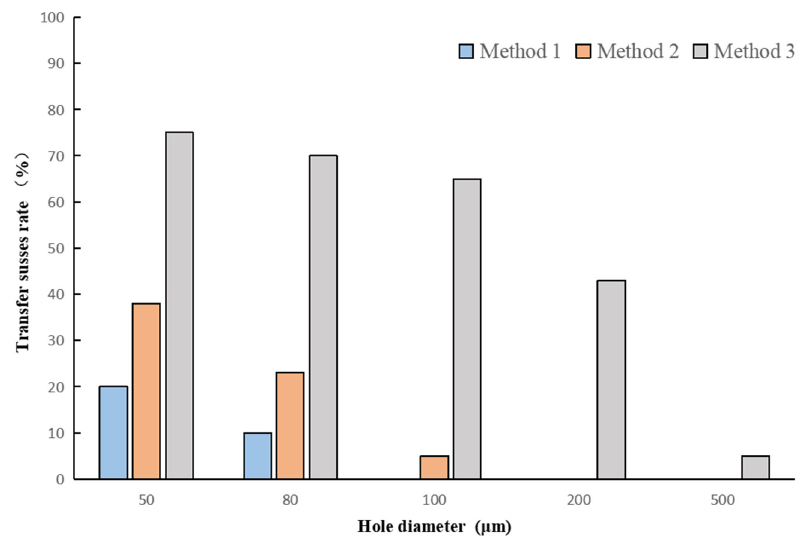
Figure 9. The statistics of the success rate for the three methods.